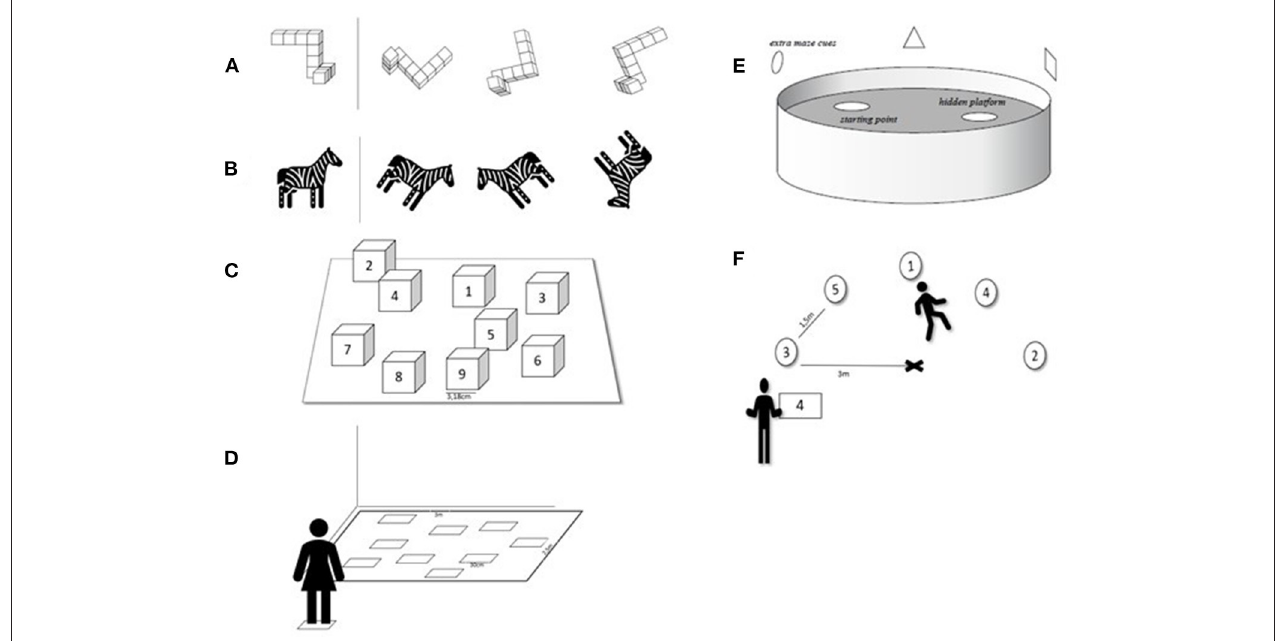
FIGURE 2 | Illustrations of the main outcome measures. Mental rotation: (A) Mental Rotation Test with three-dimensional block figures, (B) Picture Mental Rotation Test; visuo-spatial working memory/spatial memory: (C) Corsi Block Tapping Test, (D) Walking Corsi Test, (E) Virtual Reality Morris Water Maze; spatial orientation: (F) Running-Orientation